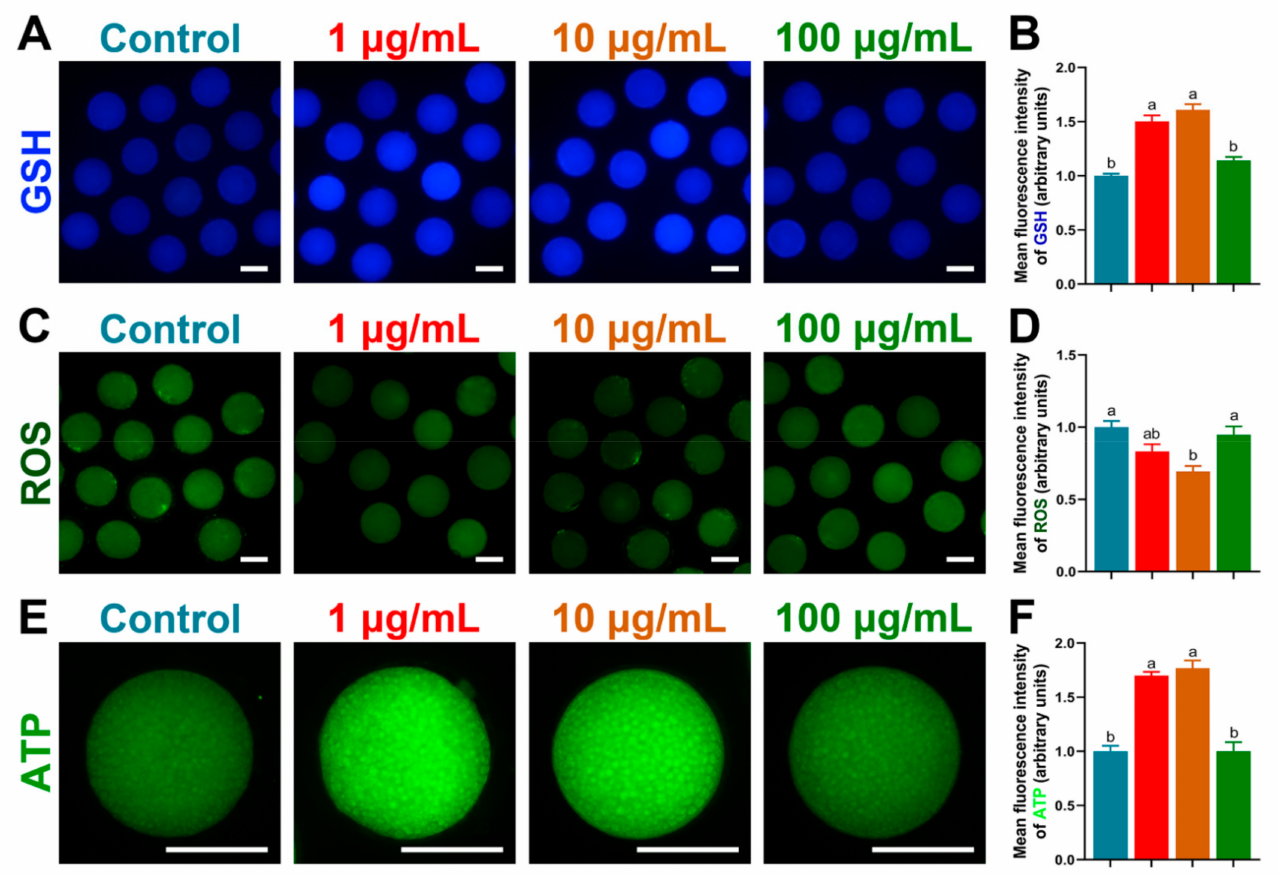
Figure 3. Analysis of GSH, ROS and ATP levels by fluorescence staining in porcine oocytes. ( A , B ) GSH levels. ( C , D ) ROS levels ( E , F ) ATP levels. Bar = 120 µ m. ( B , D , F ) Bars with different letters denote significant differences ( p < 0.05). Results are shown as the average ± SEM of at least three repeats of independent